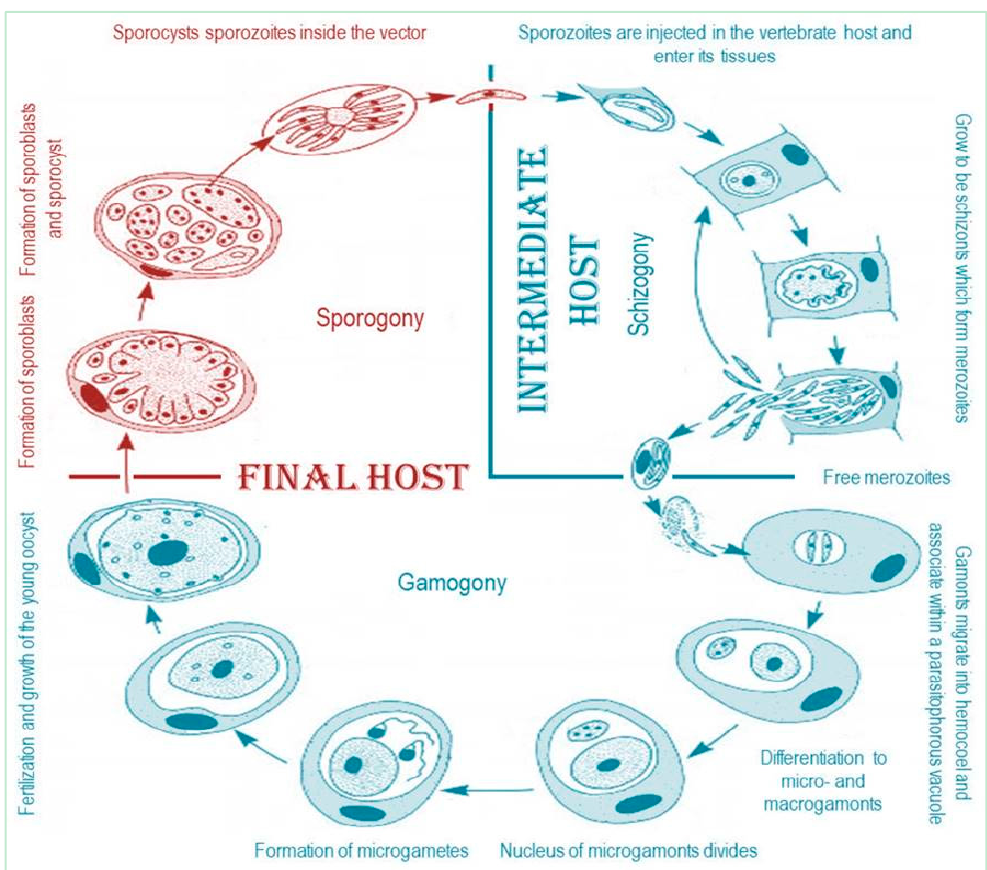
Figure 3. The life cycle of the apicomplexan parasites.